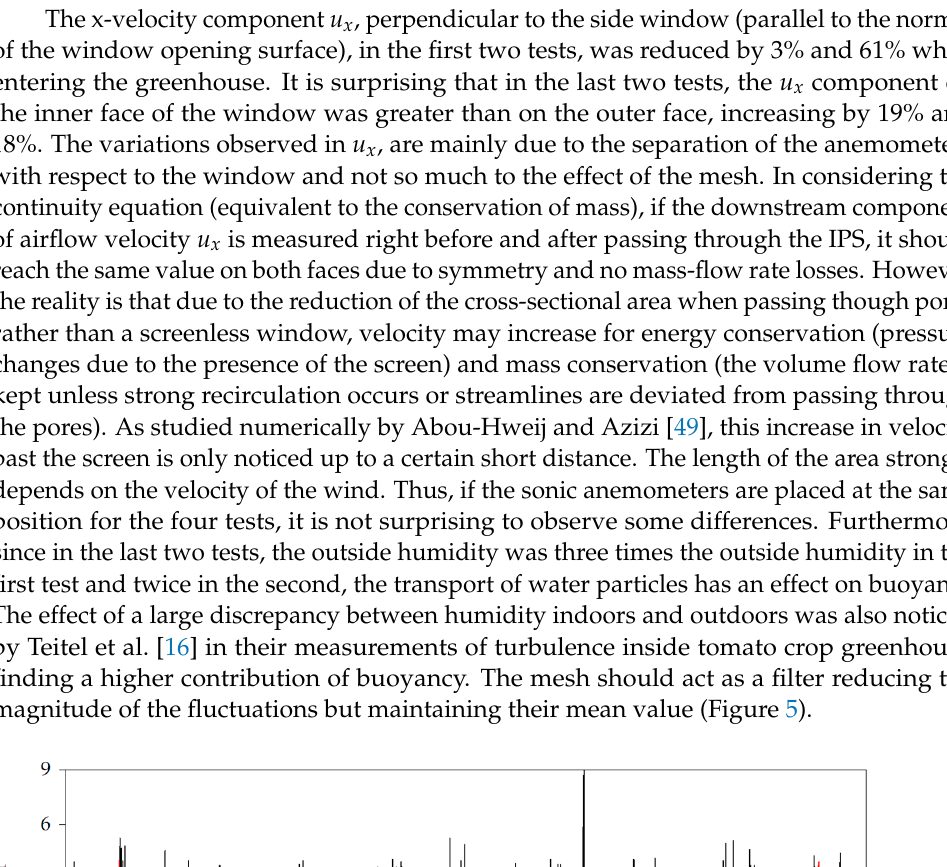
Table 6. Spectral decay slope β (slope in the longitudinal component, β x ; transversal component, β y ; vertical component, β z ).